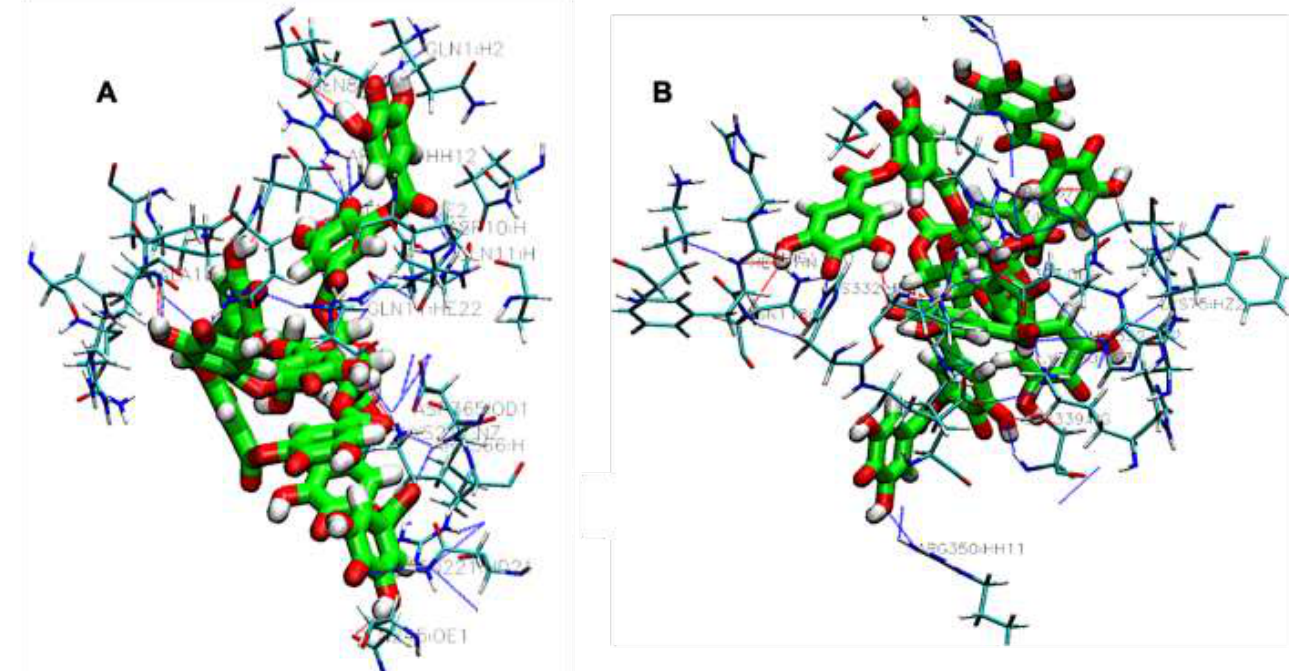
Figure 4. Three-dimensional view of protein–tannic acid interactions of the best poses generated on Canola protein ( A ), and Soybean protein ( B ).